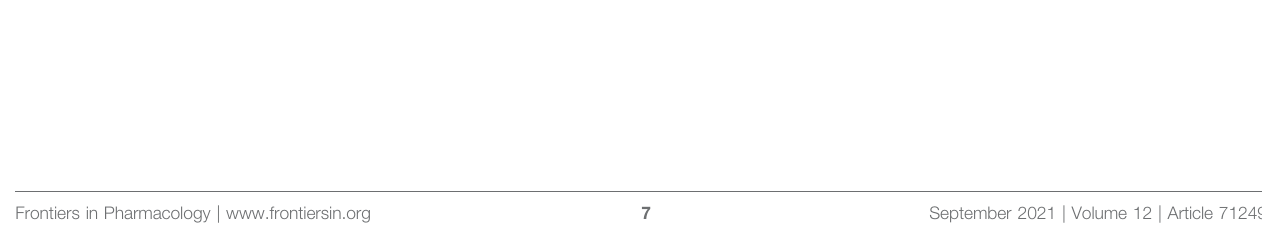
Frontiers in Pharmacology |